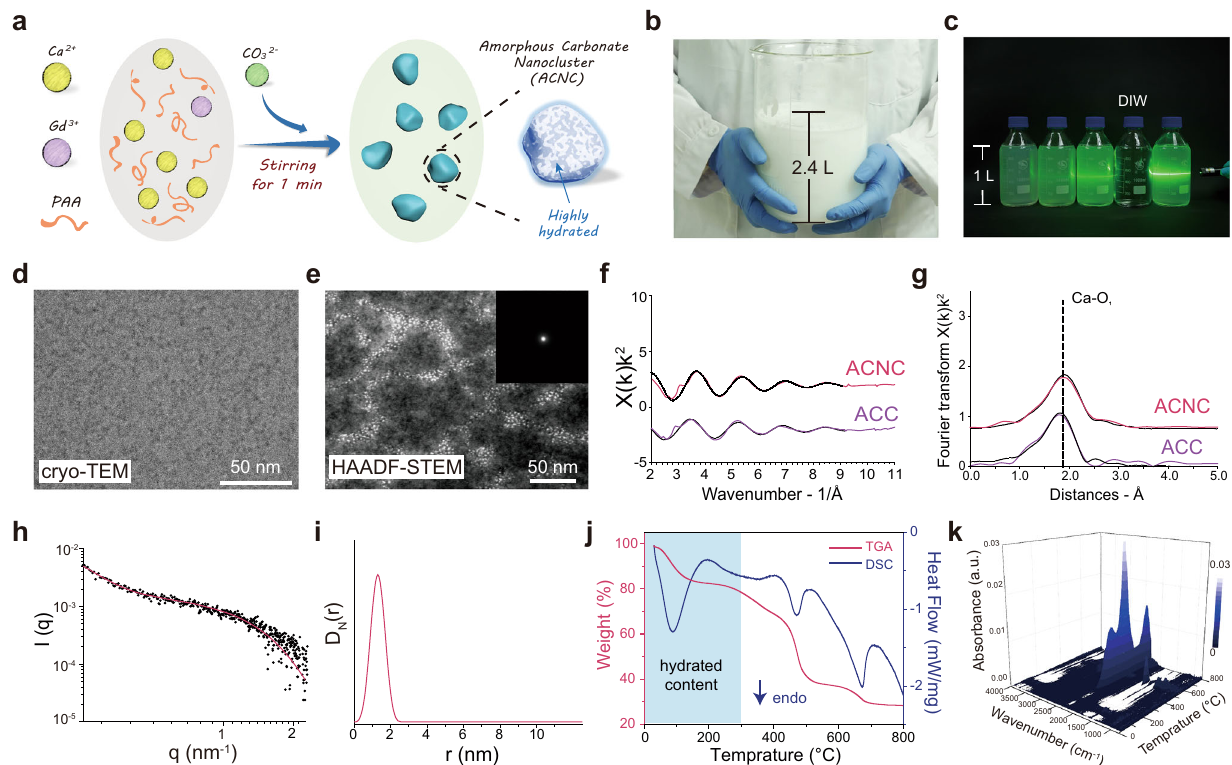
Fig. 1 | Characterization of amorphous carbonate nanocluster (ACNC). a Scheme of the synthesis process of ACNC. b Digital image of the large-scale preparedACNCwiththetotalvolumeover2liters. c DigitalimageofTyndalleffect offourlitersofACNCdispersedinnormalsaline,andonebottleofdeionizedwater was inserted (second from right). d cryo-TEM and e HAADF-STEM image of ACNC dispersed in normal saline solution. A representative image of three individual experimentsisshown.Theinsetin( e )showsSAEDofACNC.Theexperimentswere